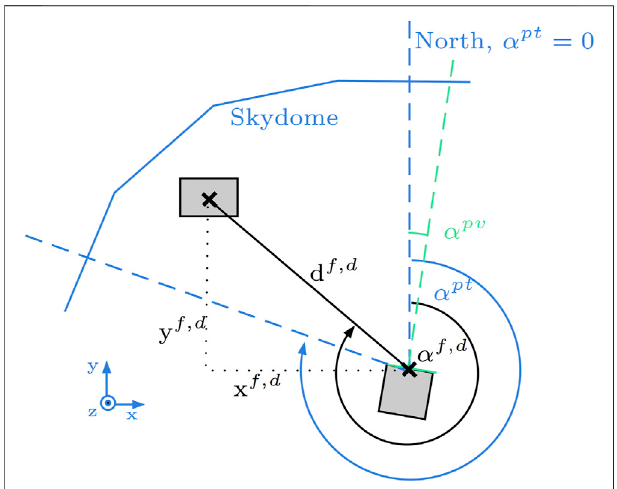
FIGURE 3 | Outline sketch of different azimuth angles. The azimuth orientation ofthefacades isidentical to possible PVmodules α pv . α f , b : azimuth direction of surrounding buildings and α pt : azimuth direction of each patch of the